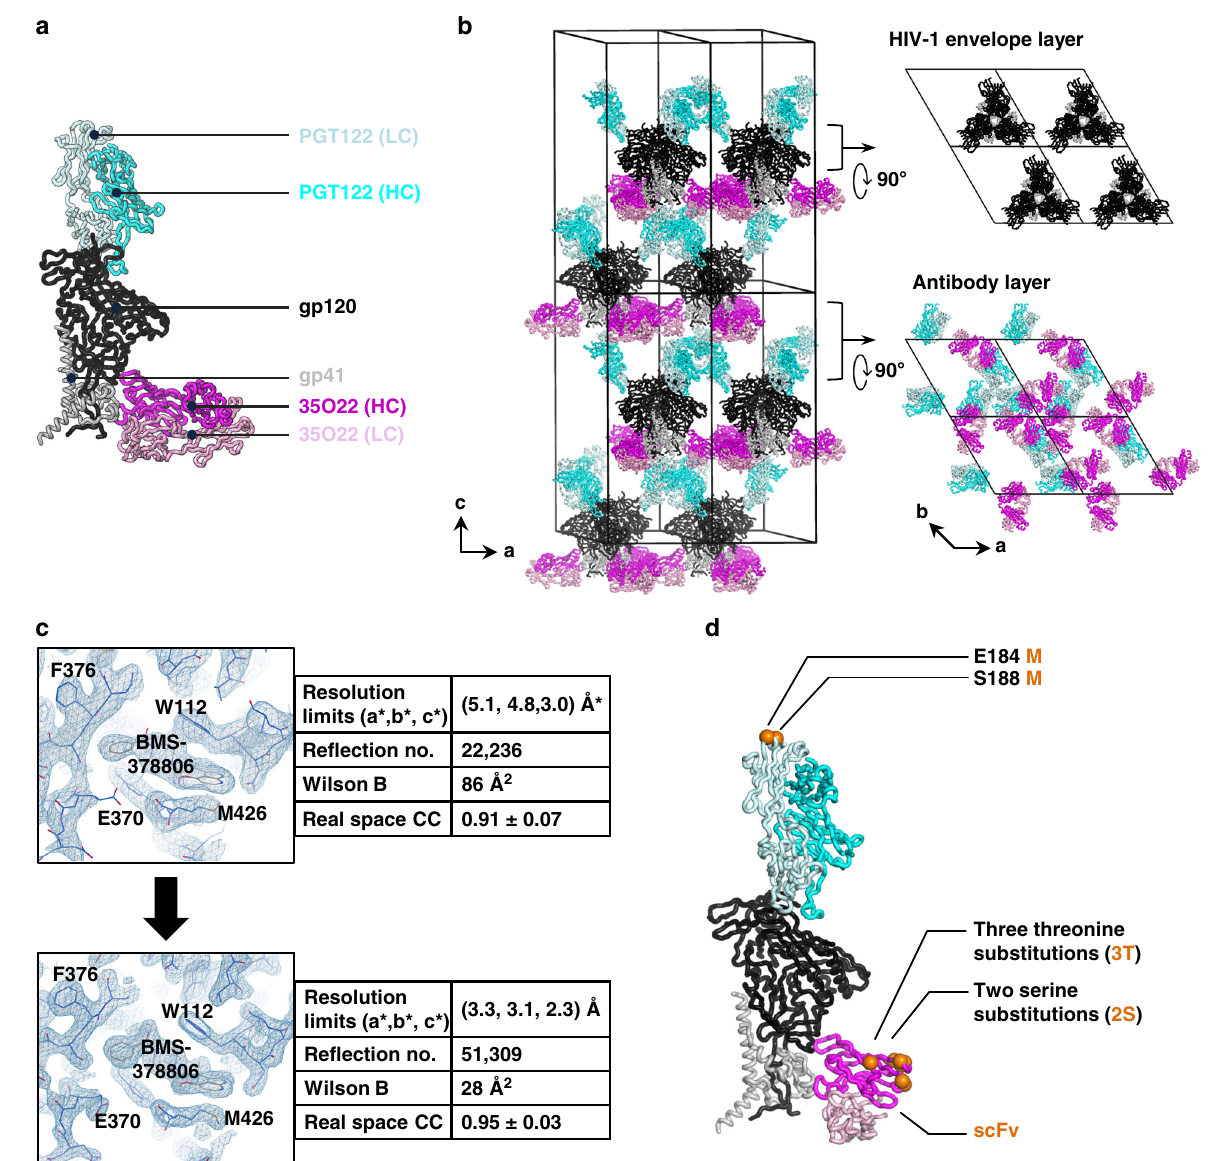
Fig. 2 Molecular assembly of an HIV-1 Env lattice with improved diffraction. a The asymmetric unit of the P6 3 lattice is shown with the PGT122 Fab colored in cyan (HC; heavy chain) and light cyan (LC; light chain); 35O22 colored in magenta (HC; heavy chain) and light magenta (LC; light chain). gp120 and gp41 of BG505 SOSIP.664 Env trimer are colored as black and gray respectively. b Crystal packing within the P6 3 lattice, highlighting the lack of crystal contacts between Env trimers (top right). c Maps and diffraction statistics before and after lattice engineering. 2Fo-Fc electron density maps of the BMS- 378806 binding pocket, shown as blue mesh, are contoured at 2 σ . ( * The original data were truncated with different criteria. For fair comparison, the structure factor was downloaded from the Protein DataBank and the same criteria applied for truncation.) d Summary of the best changes identi fi ed in the antibody fragments to improve the